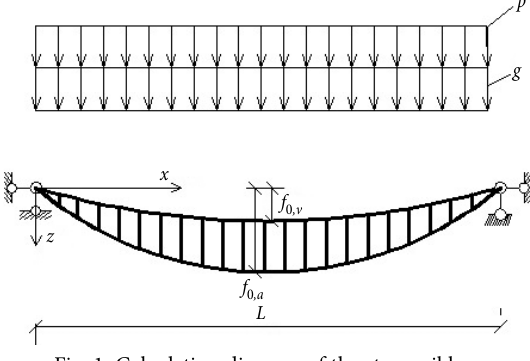
Fig. 1. Calculation diagram of the stress-ribbon with external